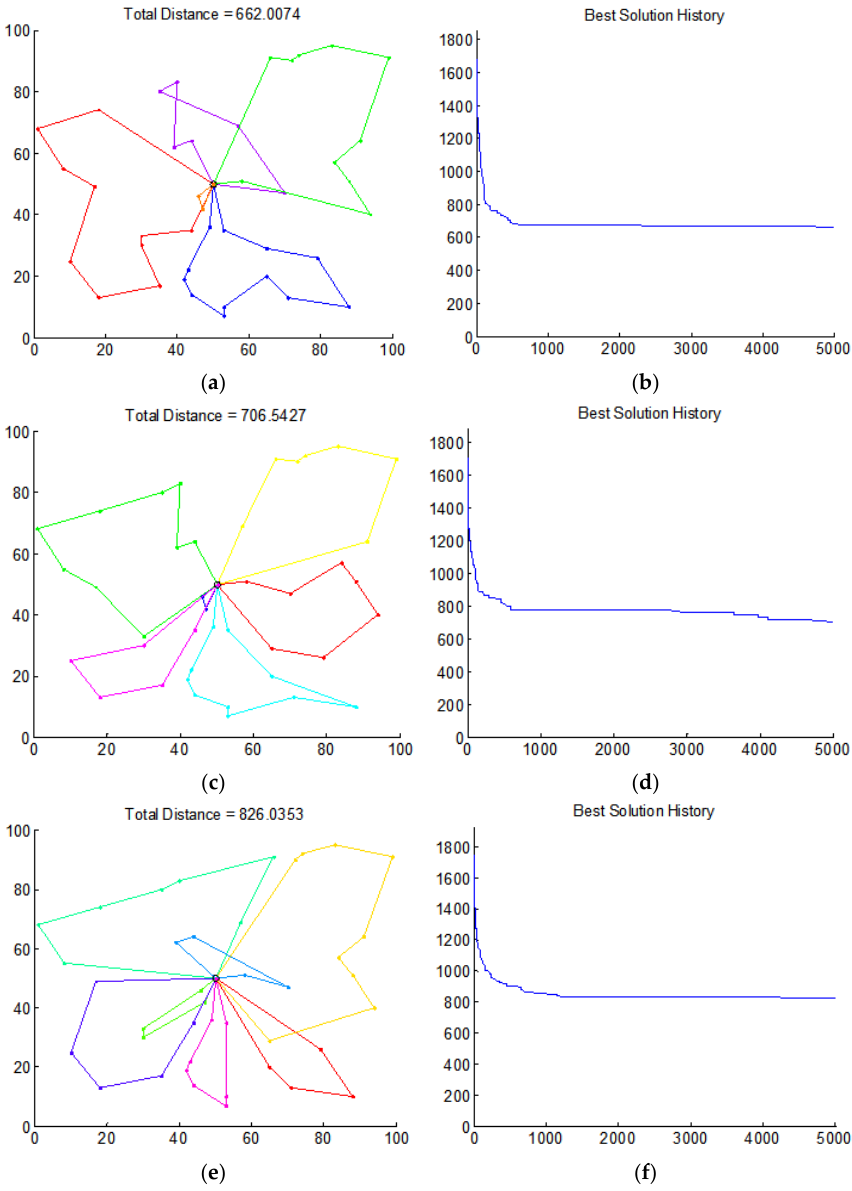
Figure 7. Distribution sequence, using the simple GA, ( a , b ) for 5 vehicles, ( c , d ) for 6 vehicles, and ( e , f ) for 7 vehicles. For ( a , c , e ), the x - and y -coordinates correspond to a position on a map. For ( b , d , f ), the x -coordinate corresponds to the number of generation, and the y -coordinate corresponds to the total distance in